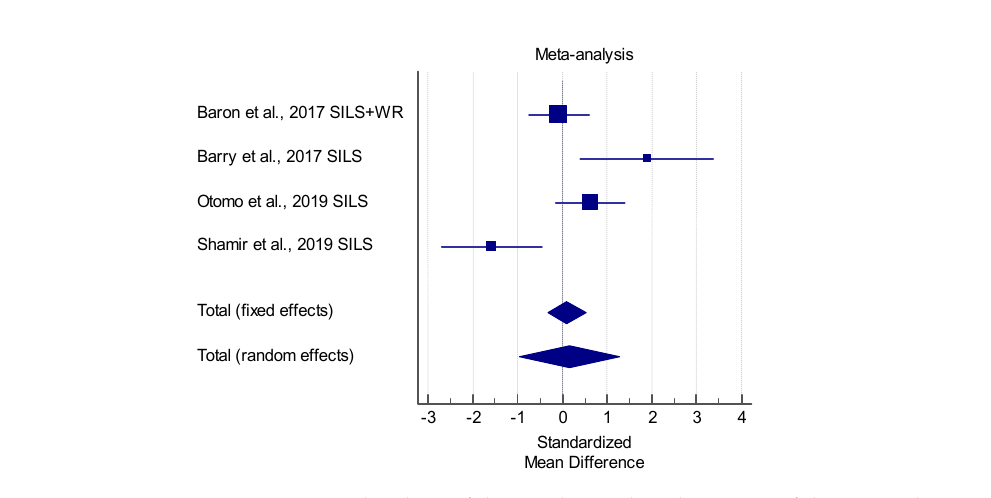
Figure 3. Forest-plot chart of the articles analyzed in terms of the surgical time of Ovariectomy (OVE) procedures. OT: operative telescope; SILS: SILS port platform. (Q 38.2976; I 2 92.17%; p < 0.0001).